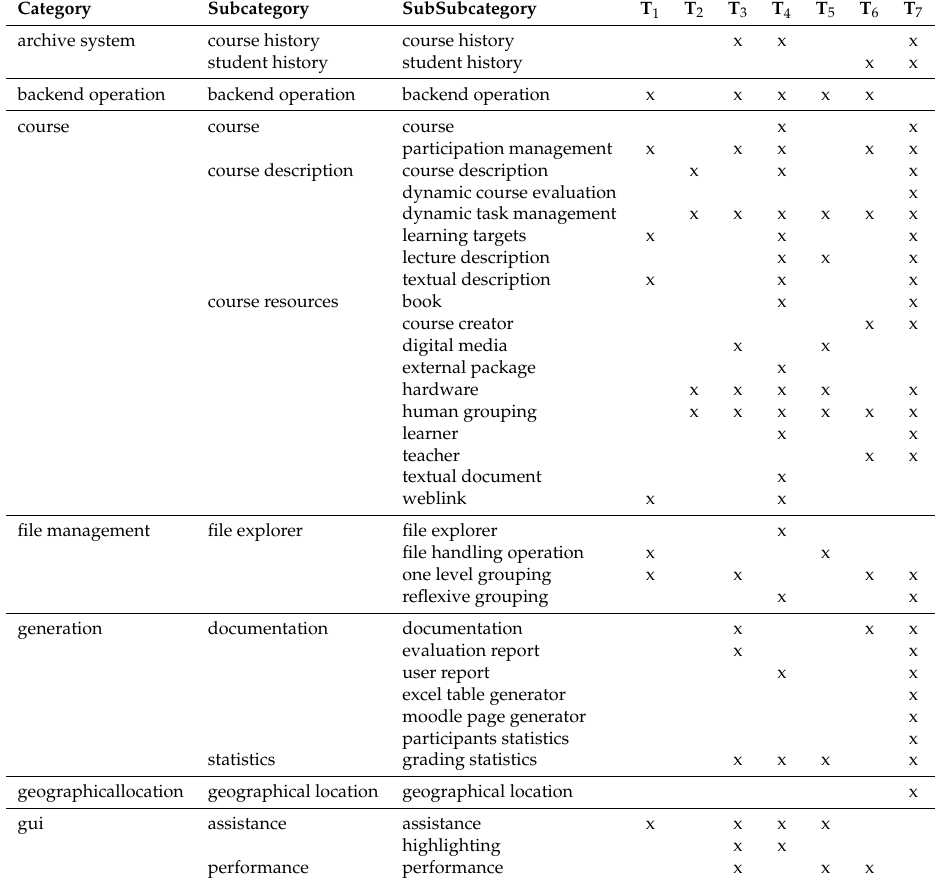
Table A3. TESMA feature